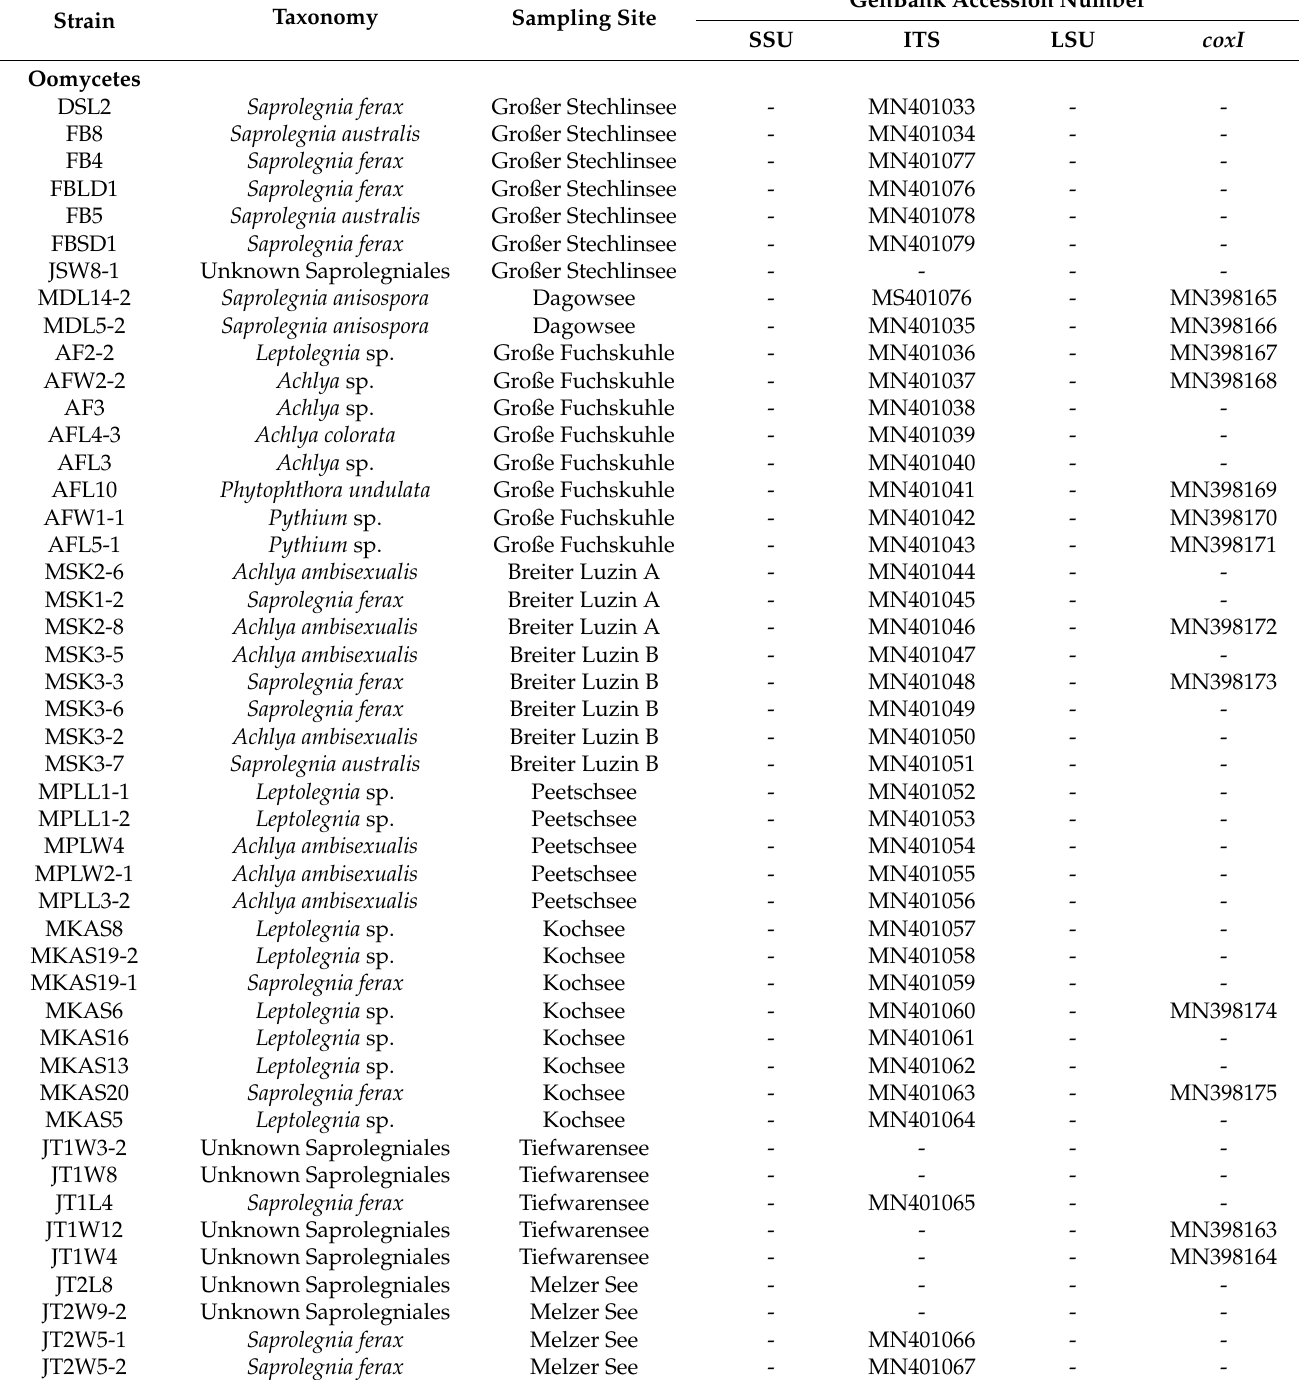
Table 1. Fungal and oomycete strains isolated from 12 temperate lakes in Northeast